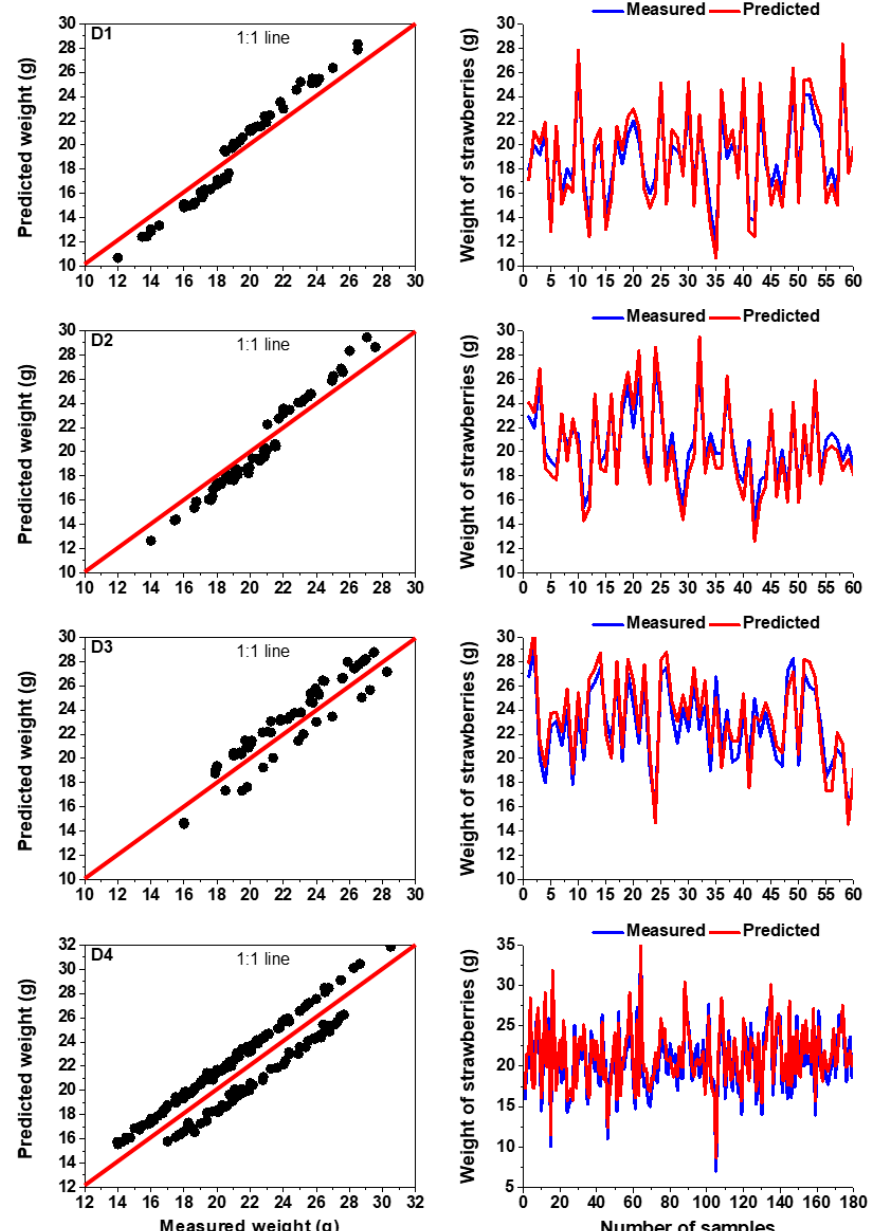
Figure 7. Scatter plots with 1:1 line and time series graph for comparing results between measured and predicted values by SVR model with D1, D2, D3, and D4 datasets for fruit weight prediction of strawberries in the testing period. D1: Measured vs. predicted data for Maehyang cultivar; D2: Measured vs. predicted data for Seolhyang cultivar; D3: Measured vs. predicted data for Santa cultivar; D4: Measured vs. predicted data for all three cultivars.